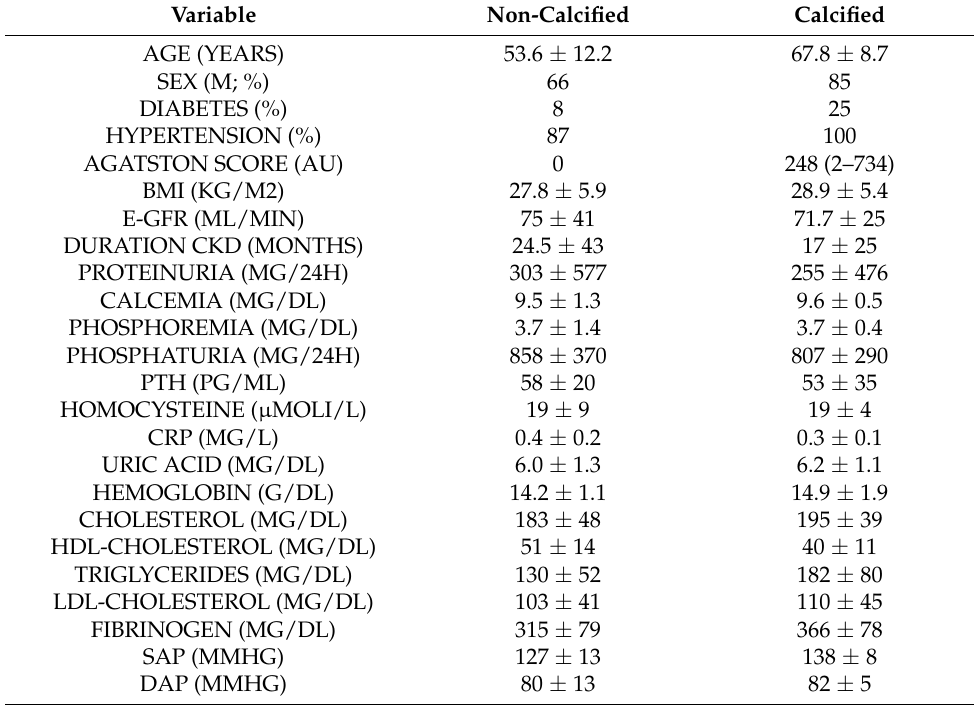
Table 3. Patients’ clinical and biochemical